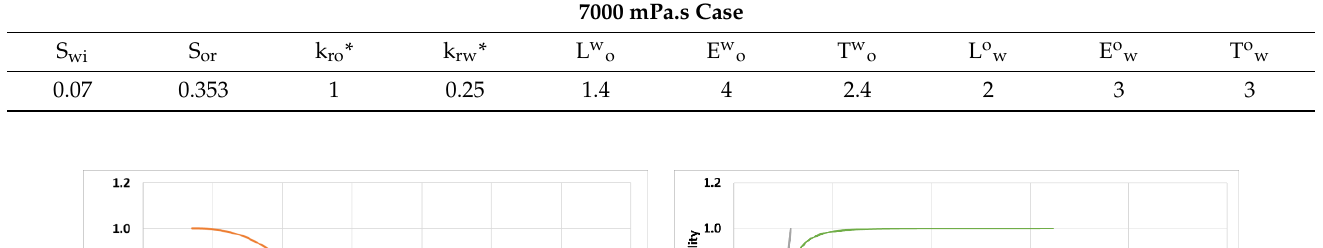
Table 4. LET input parameters for the 7000 mPa.s oil displacement case.